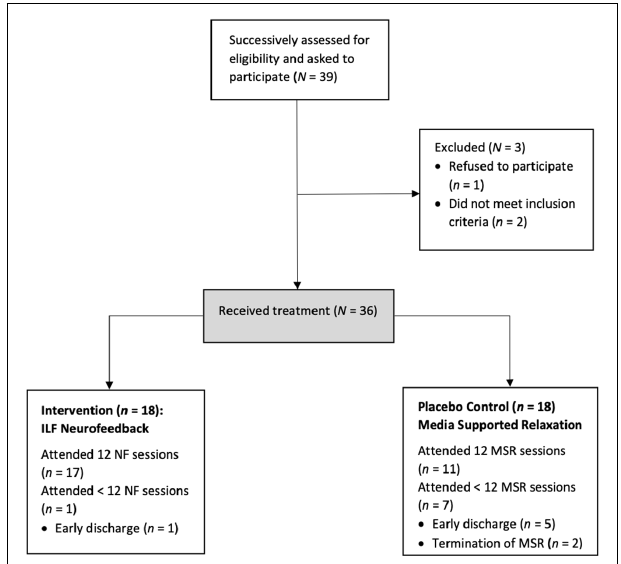
FIGURE 2 | Participant flow.